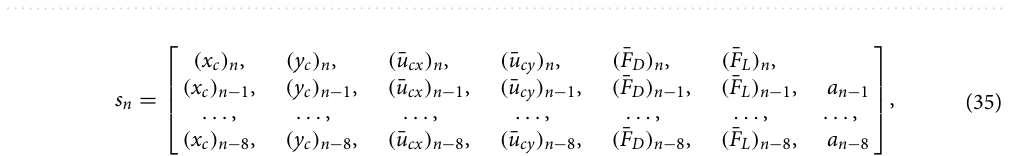
Figure 15. Wake vorticity contours during rheotaxis: ( a ) Pattern 1; and ( b ) Pattern 2. The range of the vorticity 4 to 4. Flow visualization is achieved by using Tecplot 360 EX 2015 R2 (https ://www.tecpl contours is from −